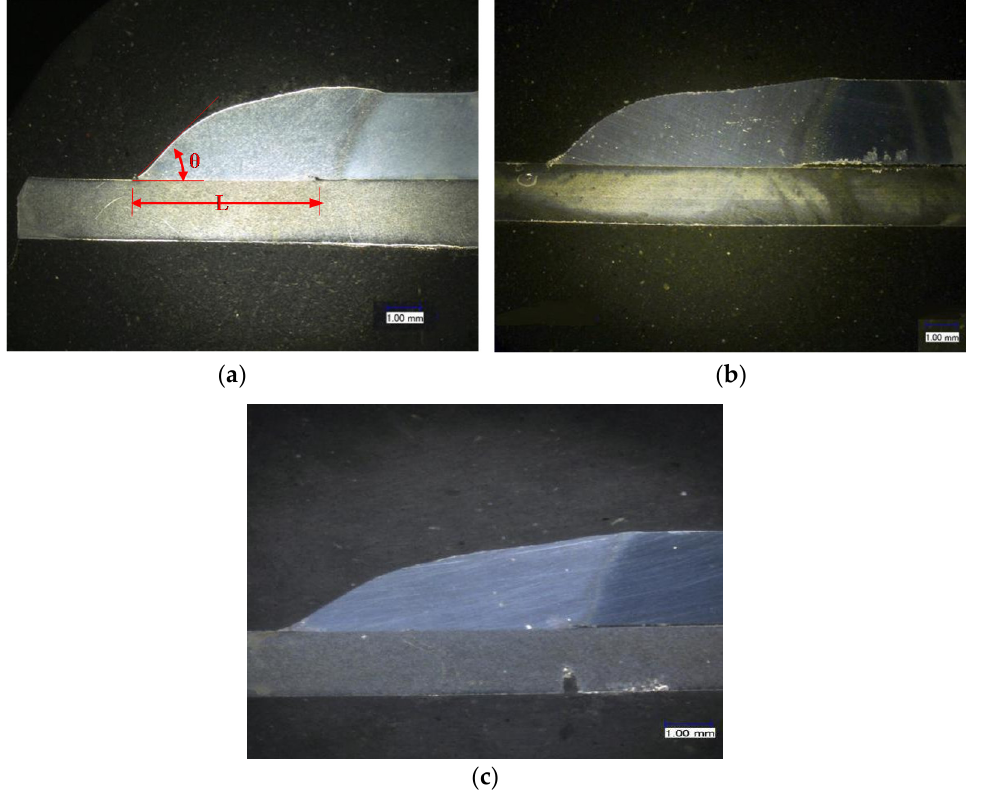
Figure 6. Metallographic cross sections for overlap welding–brazing at different preheating temperatures. ( a ) Without preheating; ( b ) 100 °C; ( c ) 200 °C .